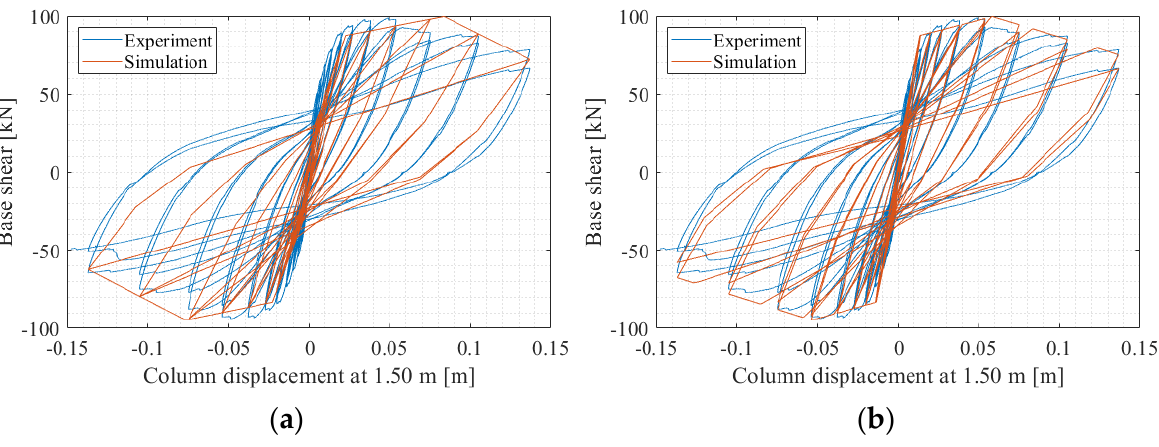
Figure 5. Base shear—displacement at height 1.50 m relationship observed during cyclic test and that obtained from simulation of cyclic response of a column reinforced with B500B using ( a ) basic and ( b ) calibrated model.